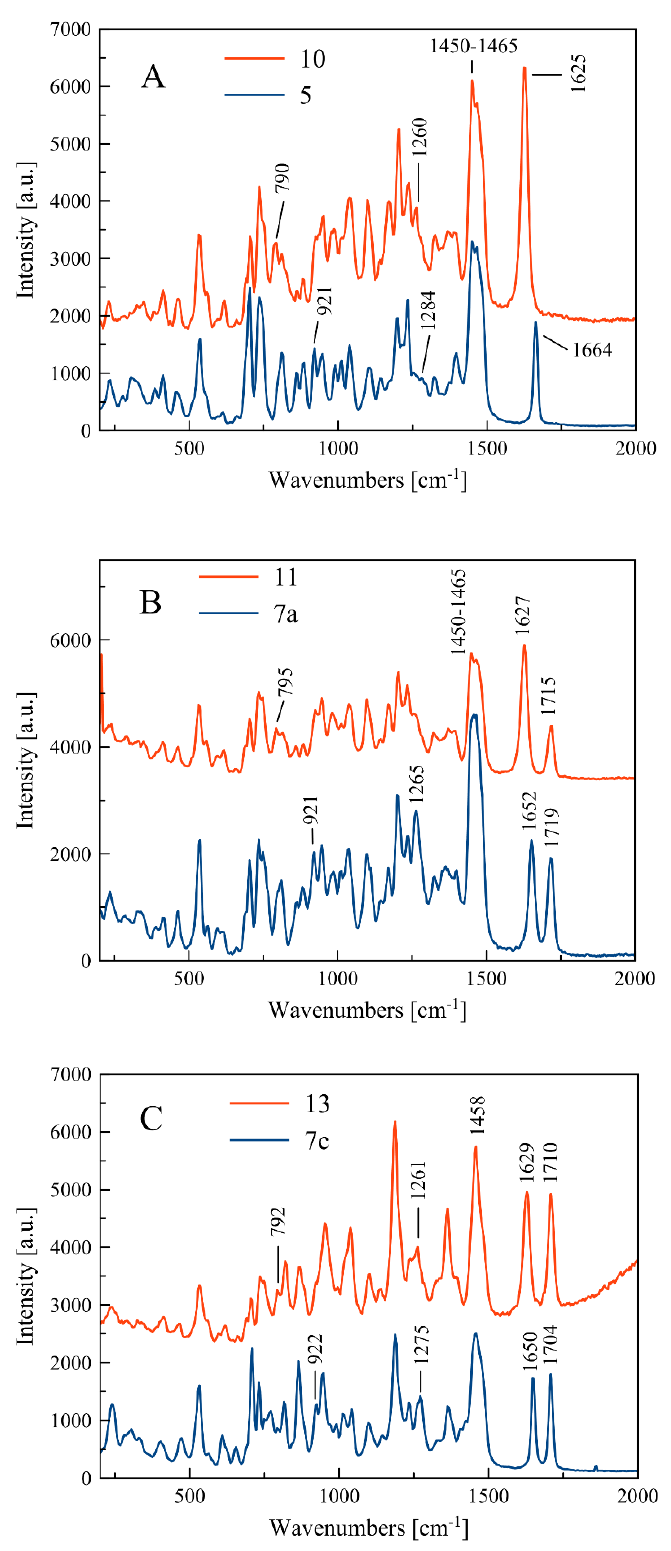
. Figure 3. Experimental Raman spectra in the range 200–2000 cm − 1 for three sets of compounds: Figure 3. Experimental Raman spectra in the range 200–2000 cm -1 for three sets of compounds: ( 5 , ( 5 , 10 ) ( A ), ( 7a , 11 ) ( B ), and ( 7c , 13 ) ( C ). 10 ) A , ( 7a , 11 ) B , and ( 7c , 13 ) C . Within each set of the compounds there is a band shift ( ∆ ν c=c) exp due to different The frequencies of the individual C=C stretching bands νc=c for the studied com- positions of the C=C bond in the side chain. For compounds 5 and 10 , the change pounds are summarized in Table 2.